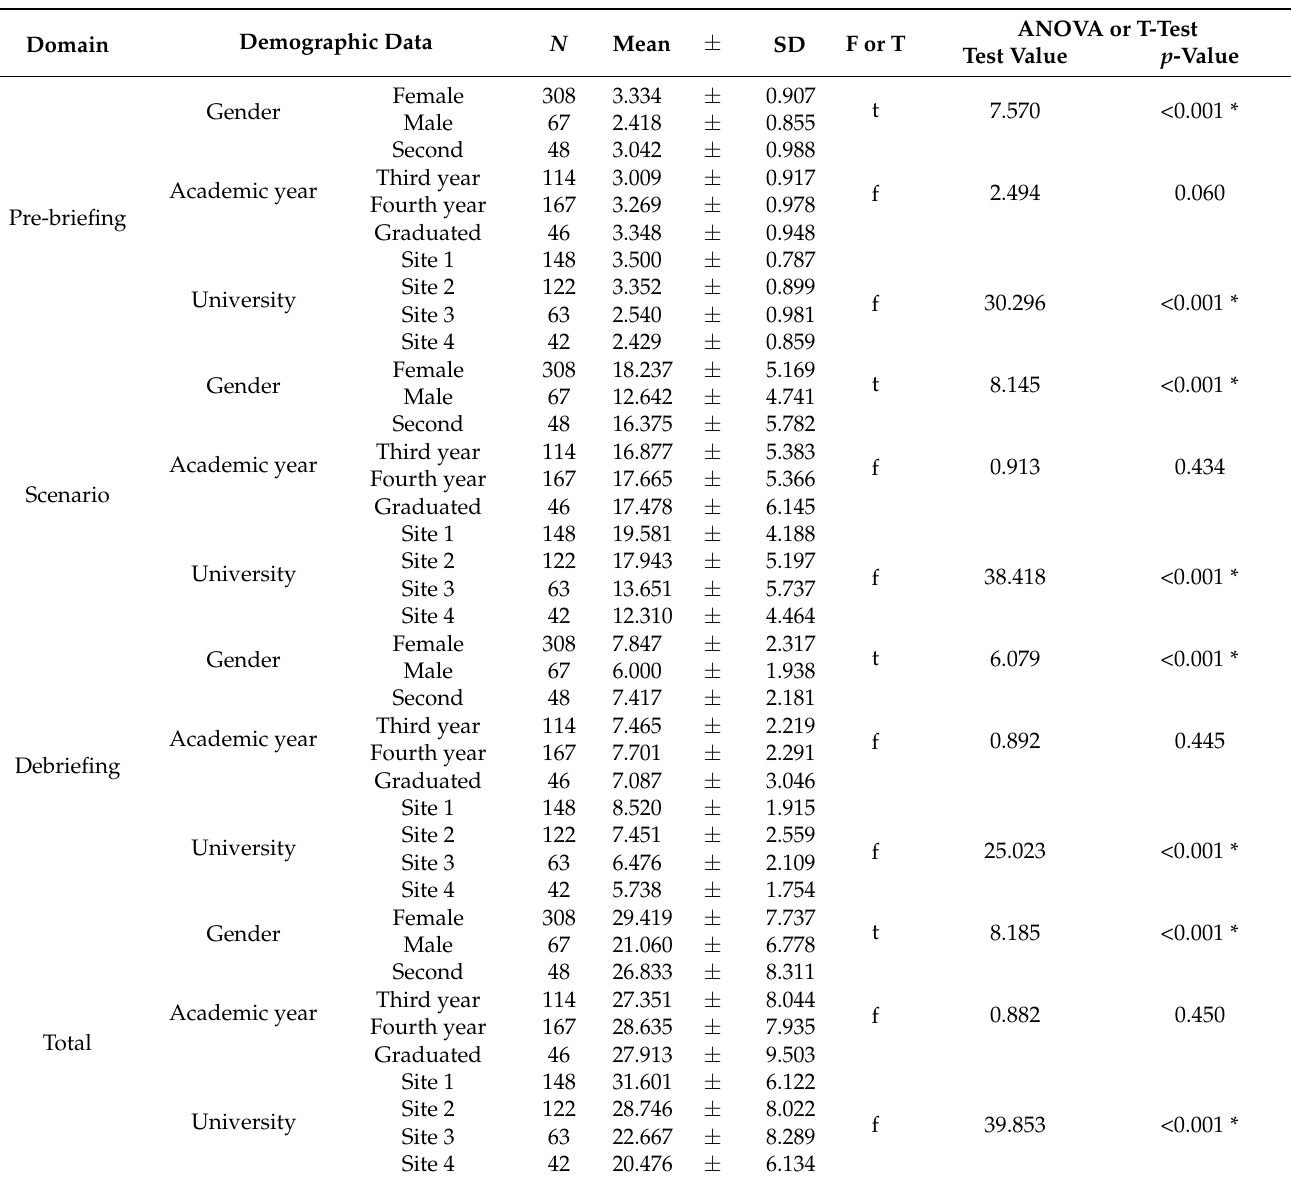
Table 4. The relation between domains and demographic data (Age, Gender, GPA, Academic year, University) study group ( n =